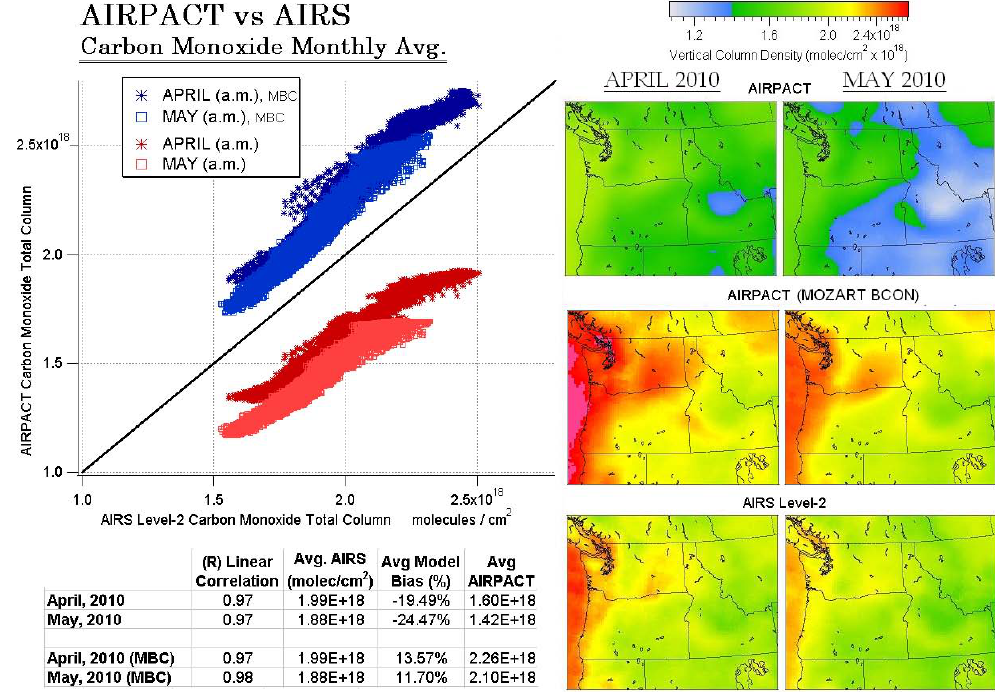
Fig. 5. Nighttime ( ∼ 02:00 a.m. PST) carbon monoxide total column monthly averages for April and May of 2010. The linear correlation of AIRPACT-3 vs. AIRS CO is plotted (left) with original AIRPACT-3 in red and MOZART BCON-updated AIRPACT-3 in blue. Corresponding maps of the region (right) show the distribution of CO across the domain. Note: the AIRS averaging kernels have not been applied to the AIRPACT-3